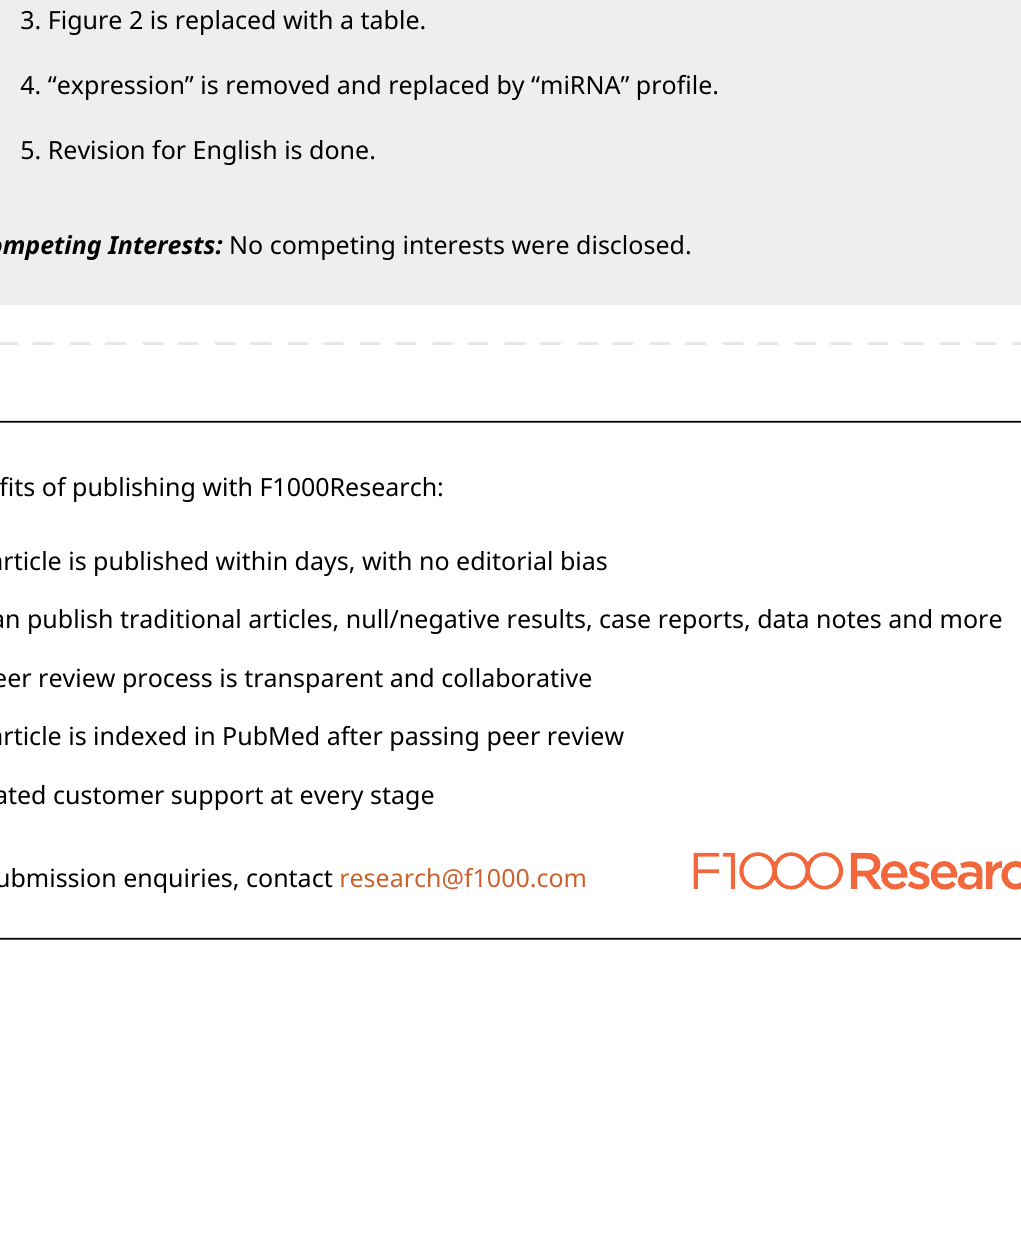
Figure 1 is removed from the paper. 2. Figure 2 is replaced with a table. 3. “expression” is removed and replaced by “miRNA” profile. 4. Revision for English is